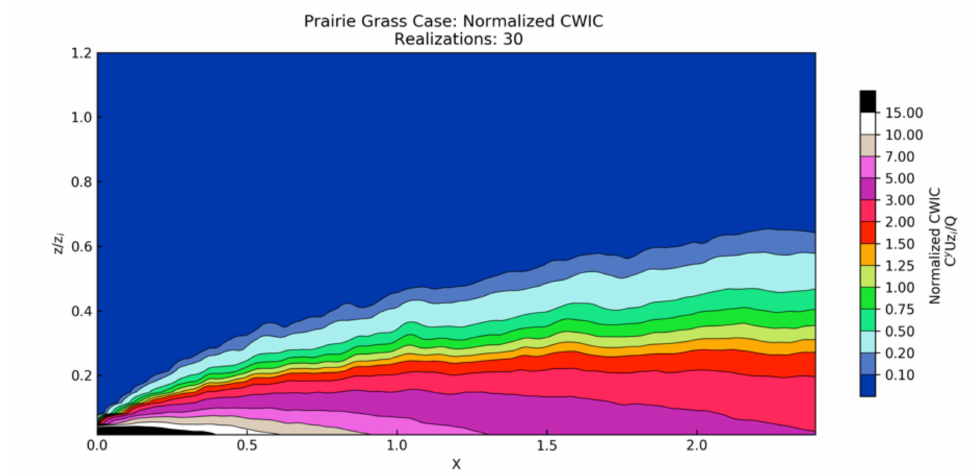
Figure 10. Normalized crosswind integrated concentration as a function of the downwind distance from the release location, for the neutral stability. The plot shows the average CWIC from 30 individual GPU-LES realizations.